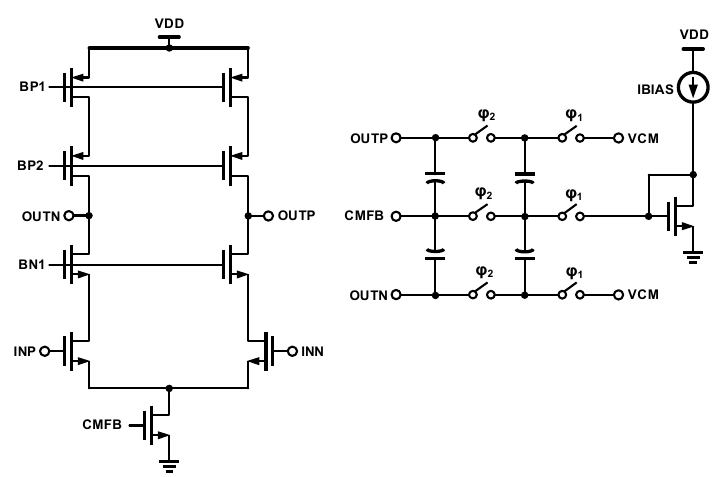
Figure 8. Telescopic cascade amplifier with switched capacitor CMFB.